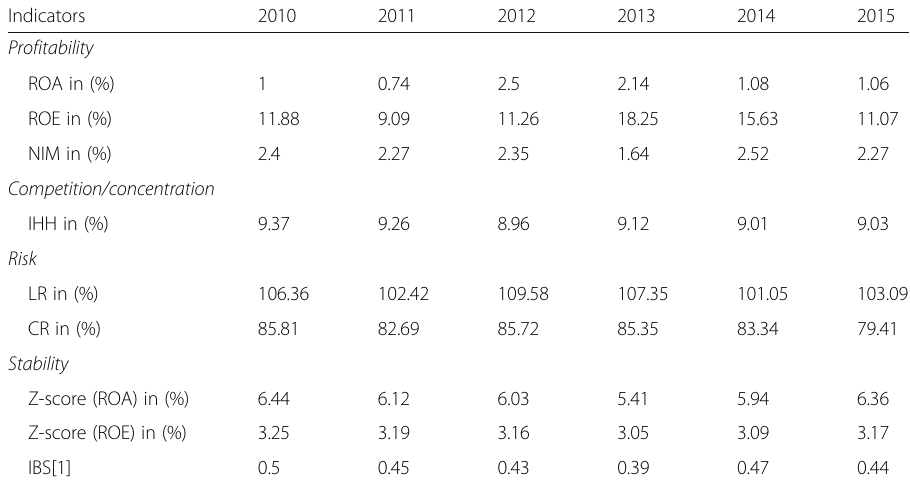
Table 1 Key indicators a of the Tunisian banking sector Indicators